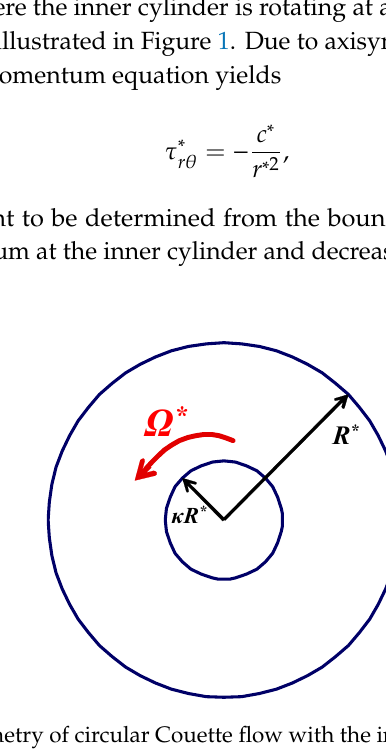
Figure 1. Geometry of circular Couette flow with the inner cylinder rotating.